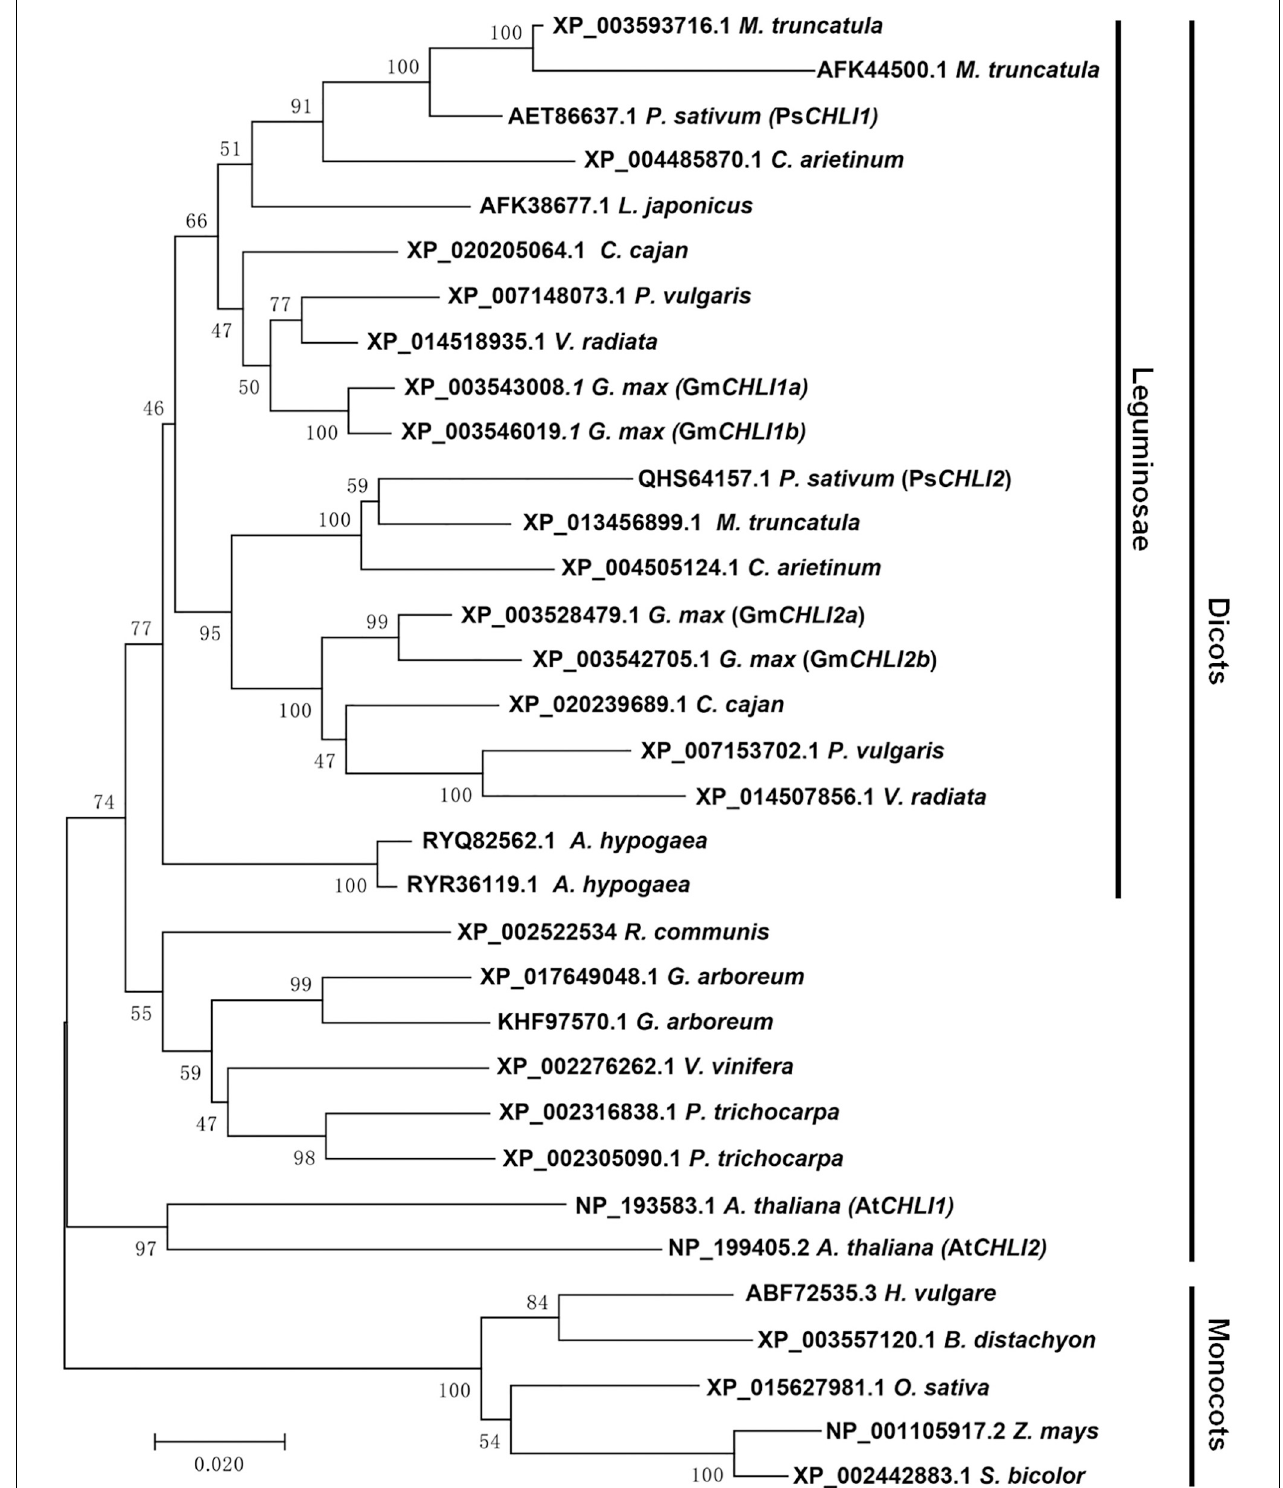
FIGURE 1 | Phylogenetic analysis of plant CHLI subunits. Using the neighbor-joining (NJ) method, a bootstrap consensus tree was constructed on the base of 33 aligned CHLI amino acid sequences from 14 dicotyledons to 5 monocotyledons.